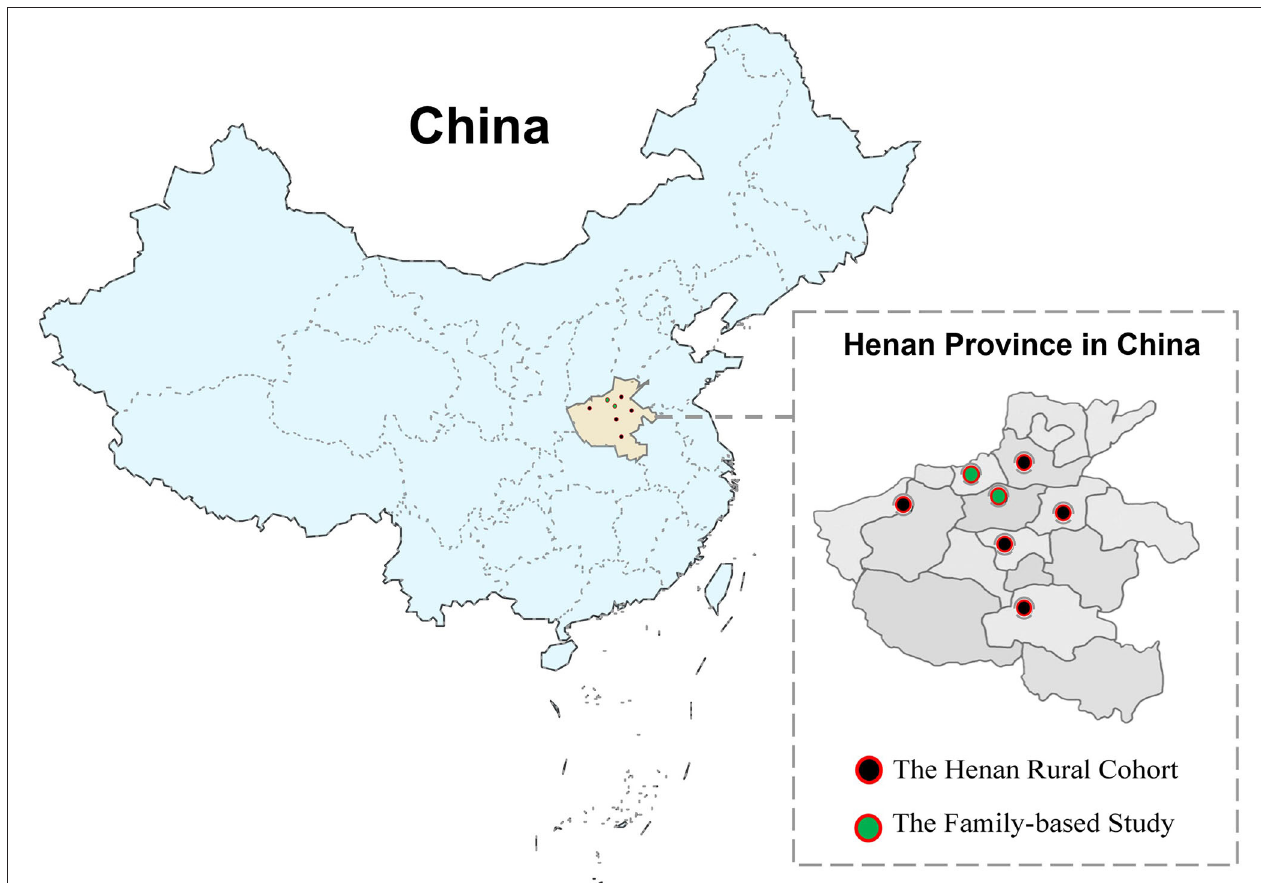
FIGURE 1 | Locations of survey sites in the Henan Rural Cohort and the family-based